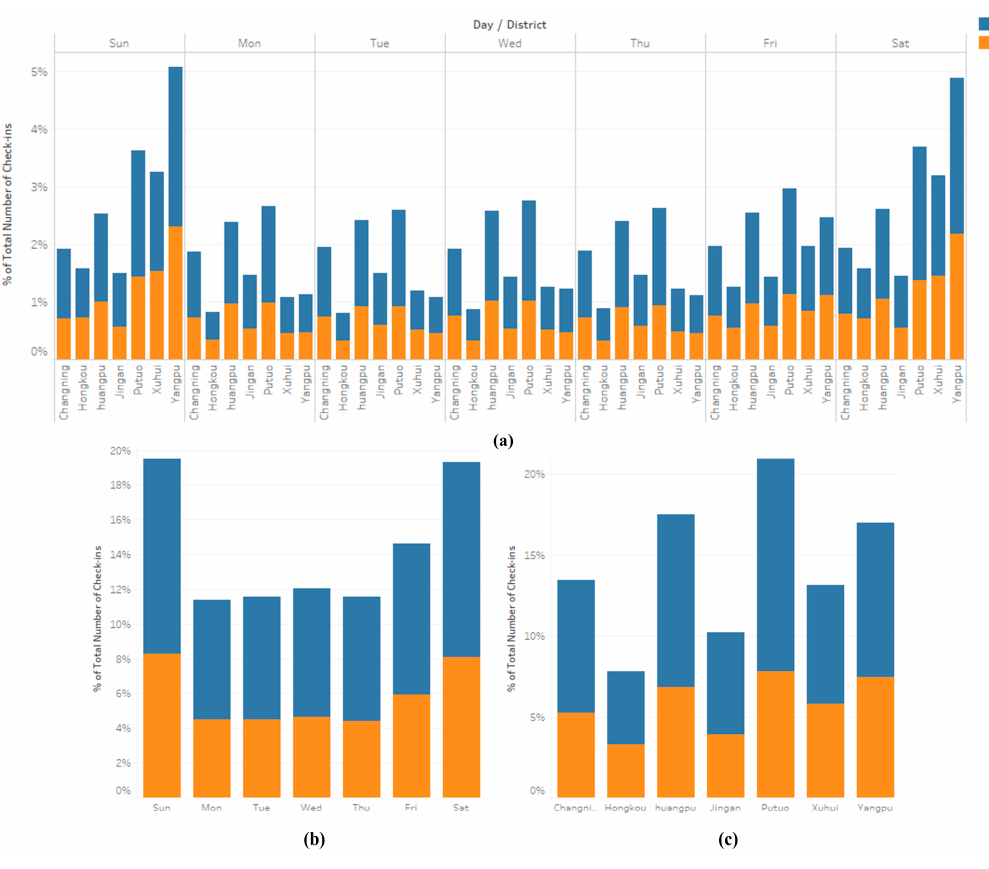
Figure 13. ( a ) Gender differences in the districts/days, ( b ) gender difference weekly, and ( c ) gender differences in the districts.